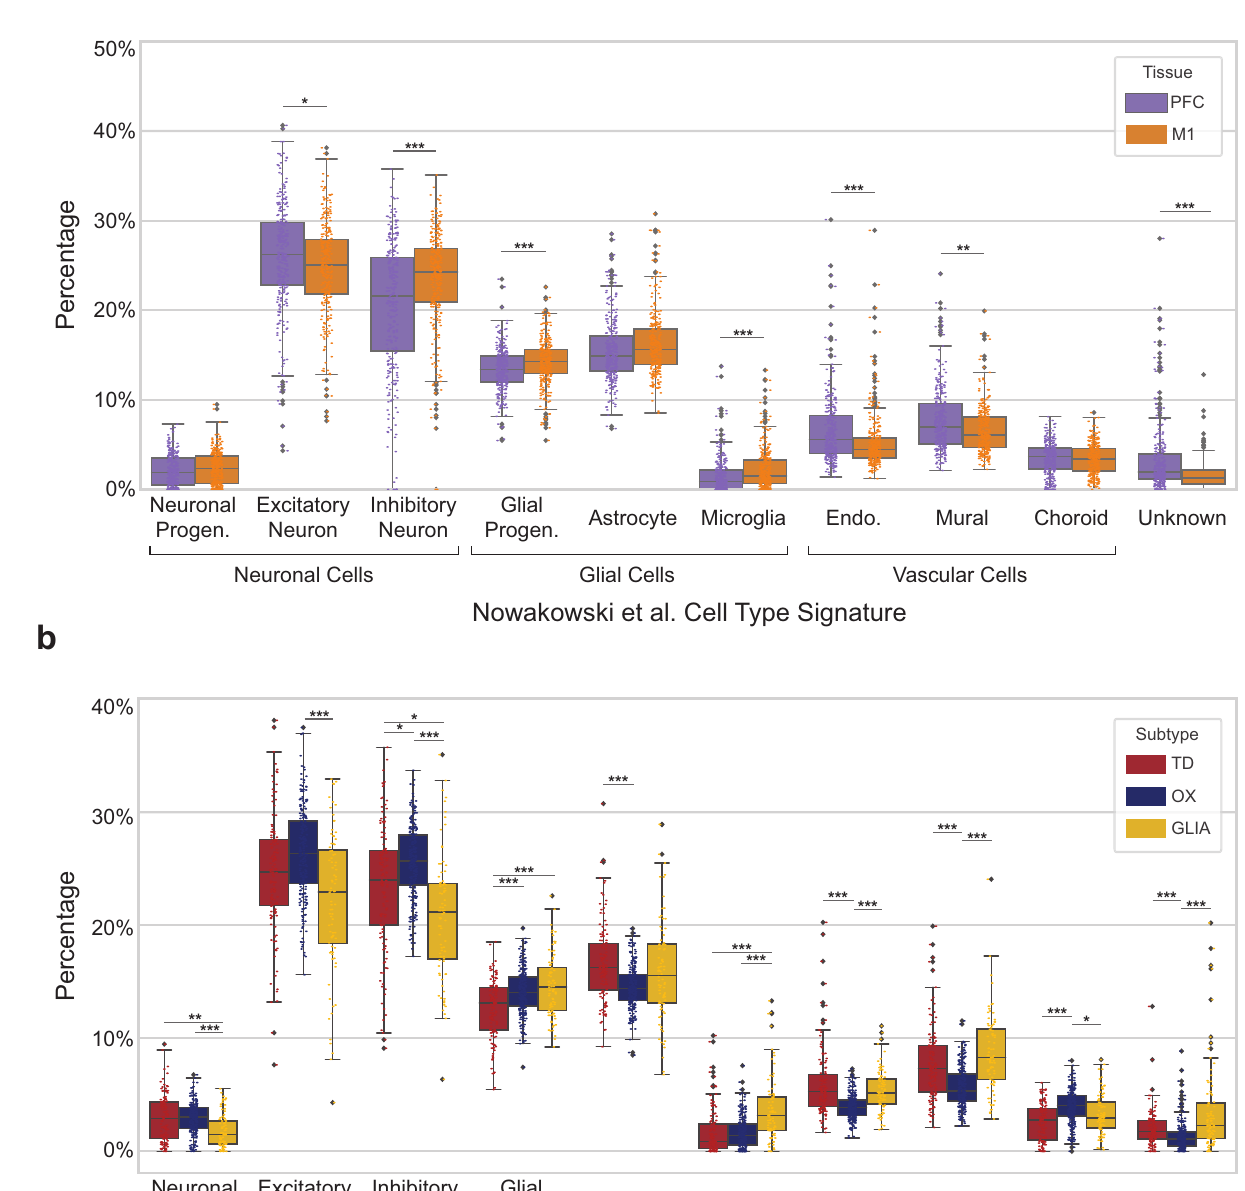
Fig.7|BulktissuecelldeconvolutioninALSsubtypes.a Celltypepercentagesin the prefrontal and motor cortices for all patient samples considered in this study. b Fractionsofcelltypesinthefrontalandmotorpostmortemcortex,consideredin the context of the ALS subtypes. Signi fi cant differences in cell type percentages were assessed using a two-sided Wilcoxon rank sum test with Bonferroni p -value adjustment. Adjusted p -values are denoted using the following scheme: *** p <0.001; ** p <0.01; * p <0.05. The median is indicated by the solid black line, and